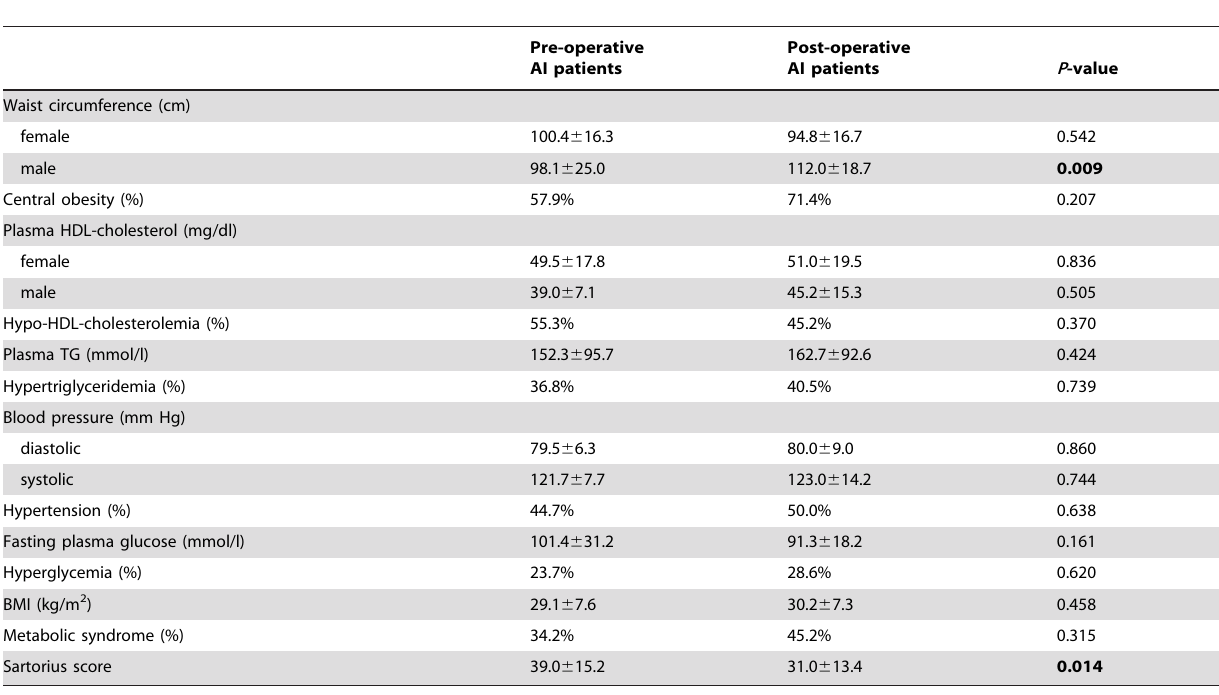
Table 3. Criteria and parameters of metabolic syndrome in pre-operative and post-operative patients suffering from AI.